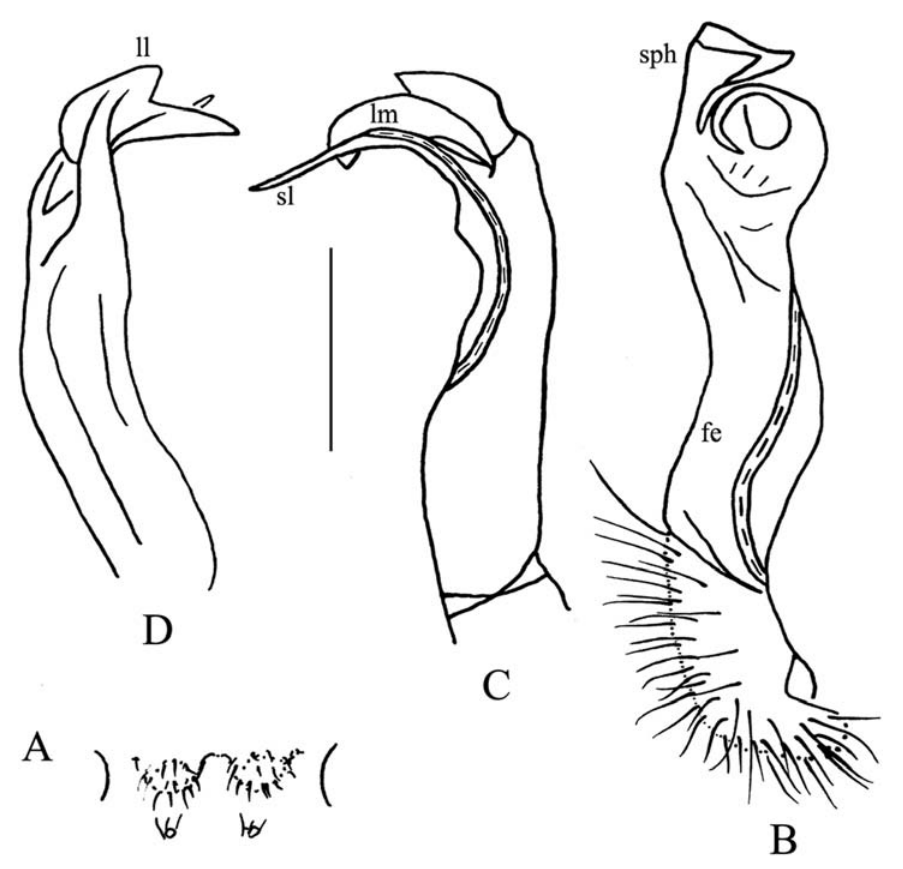
A key to Desmoxytes species currently known to occur in China 1 At least paraterga on collum and following four segments spiniform, most- ly very long and directed evidently more dorsally than laterally (Figs 3, 5). – Paraterga long and spiniform only on collum and following four segments, evidently shorter on segment 5, small and coni- to tuberculiform thereafter – Paraterga subequally long and spiniform at least in segments 2–18 (Fig. 3) ...3 Both ♂ femora 6 and 7 very evidently humped ventrally in distal quarter